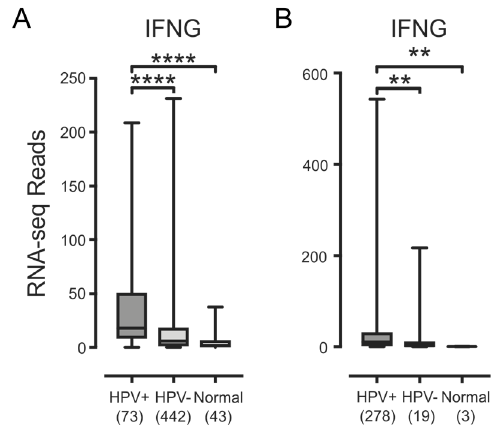
Figure 5. Detection of tumor infiltrating T-cells and NK-cells in head & neck and cervical carcinomas stratified by HPV status. Normalized RNA-seq data for genes indicative of tumor-infiltrating T cells (CD3D, CD3E and CD3G) or NK cells (FCGR3A) was extracted from the TCGA database for the HNSC ( A ) and CESC ( B ) cohorts for HPV+, HPV − , and normal control tissues. Numbers in brackets refer to the number of samples included in each analysis. * p ≤ 0.05; ** p ≤ 0.01; *** p ≤ 0.001; **** p ≤ 0.0001; ns—not significant; red brackets indicate a comparison that did not achieve significance with a power value <0.8.